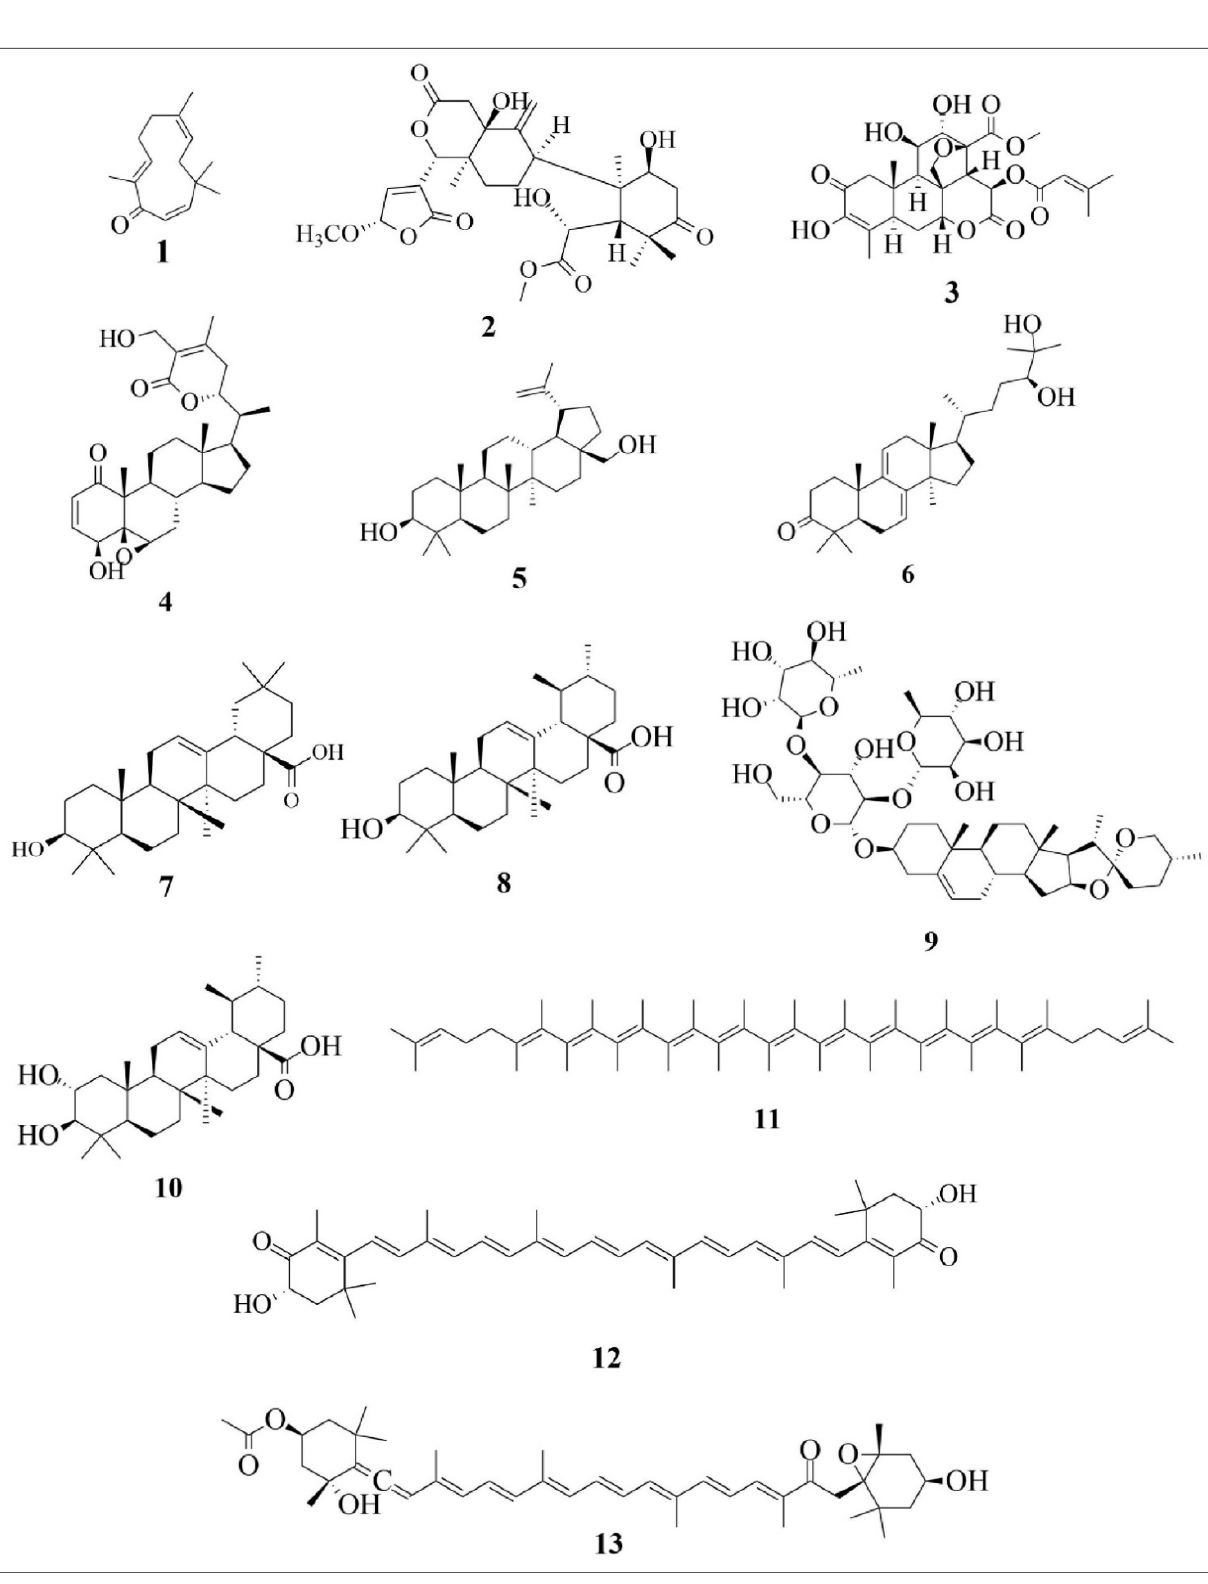
Figure 2. Chemical structures of the dietary terpenoids that can modulate the Keap1-Nrf2-ARE signaling system. ( 1 ) zerumbone, ( 2 ) khayandirobilide A, ( 3 ) brusatol, ( 4 ) withaferin A, ( 5 ) betulin, ( 6 ) ganodermanondiol, ( 7 ) oleanolic acid, ( 8 ) ursolic acid, ( 9 ) dioscin, ( 10 ) corosolic acid, ( 11 ) lycopene, ( 12 ) astaxanthin, and ( 13 ) fucoxanthin.